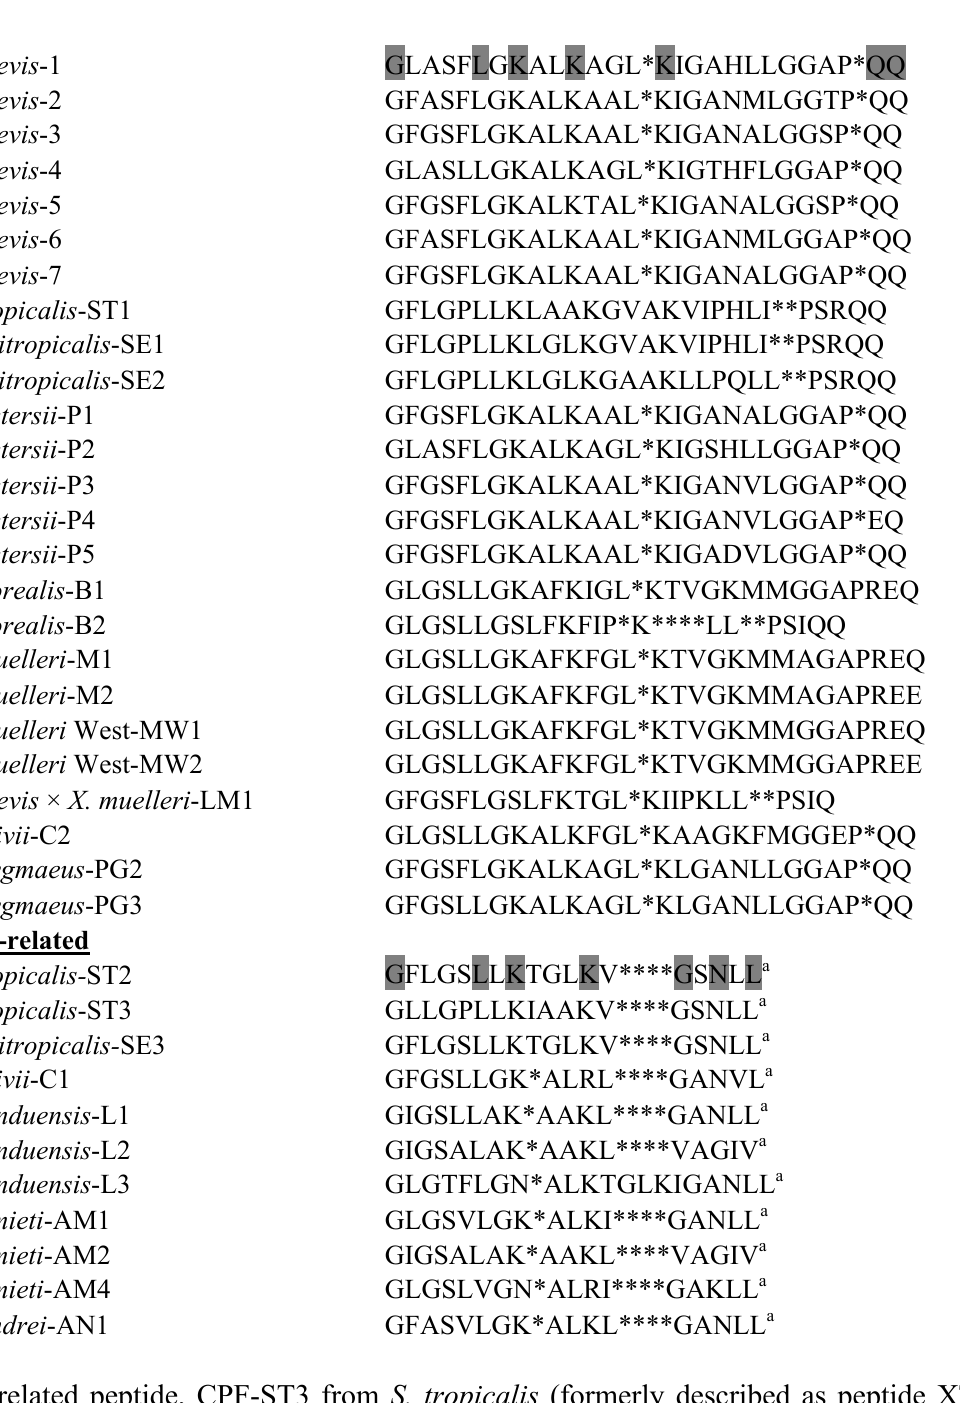
Figure 3. Primary structures of the caerulein precursor fragment (CPF) peptides isolated from skin secretions of frogs belonging to the genera Xenopus and Silurana . a denotes C-terminal α -amidation. In order to maximize structural similarity, gaps denoted by * have been introduced into some sequences. Strongly conserved residues are shaded.